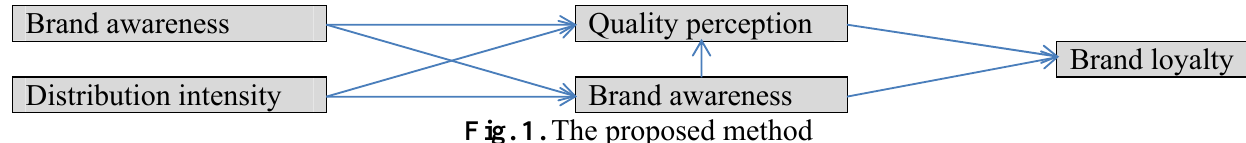
Fig. 1. The proposed method